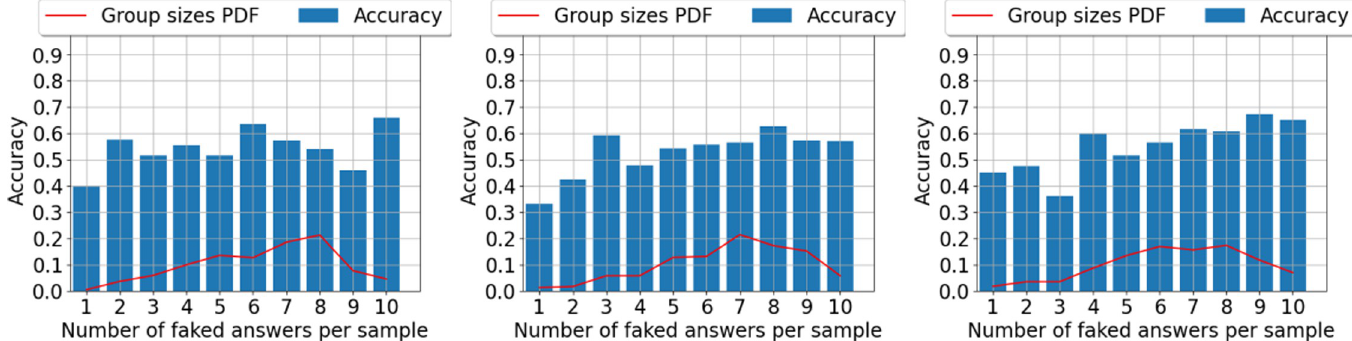
Fig 4. Probability density function. Probability density function (PDF) of the number of dishonest responses per questionnaire (red line) and per-item accuracy for the faking detection task using the TF-IDF model on various datasets: CC (left panel), JIS (central panel), and JIHO (right panel). The most frequent number of dishonest responses is 7/10. In each of the histogram’s bars, we report the average accuracy in identifying faked responses.